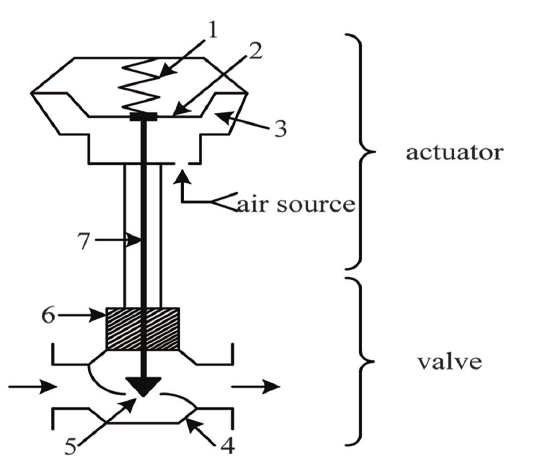
Figure 1. Actuator of a pneumatic control valve. 1: reset spring; 2: thin film; 3: membrane chamber;